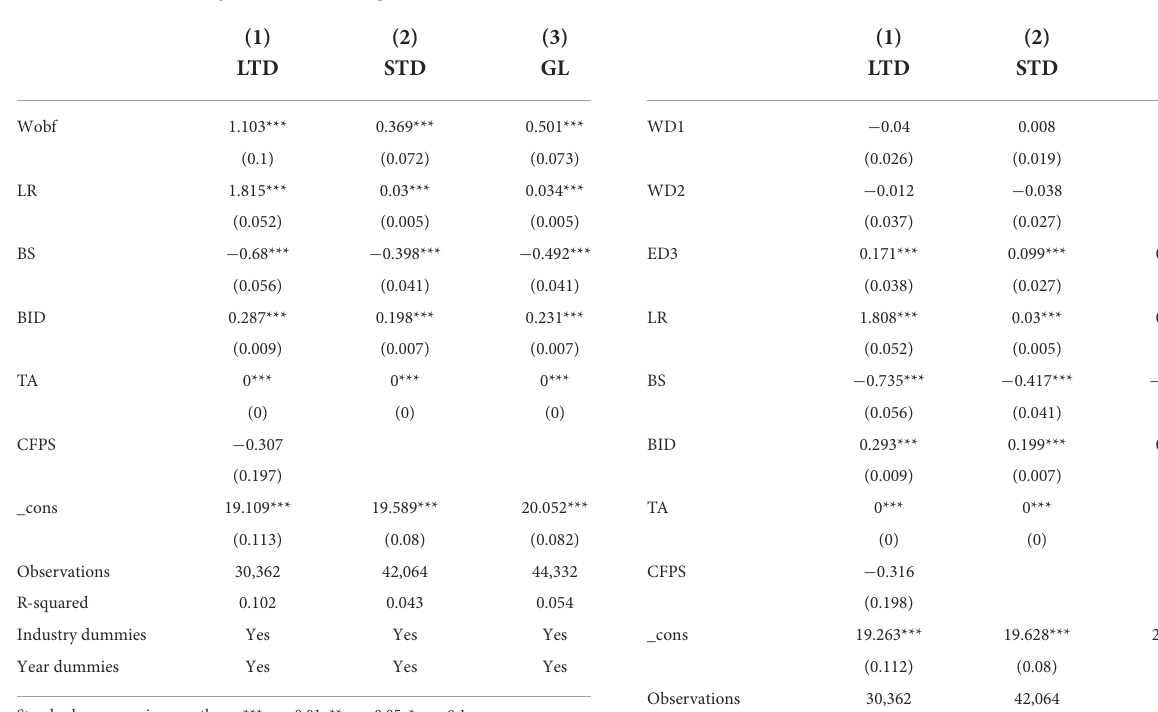
TABLE 5 Gender diversity and debt financing. TABLE 6 Fixed effect–critical